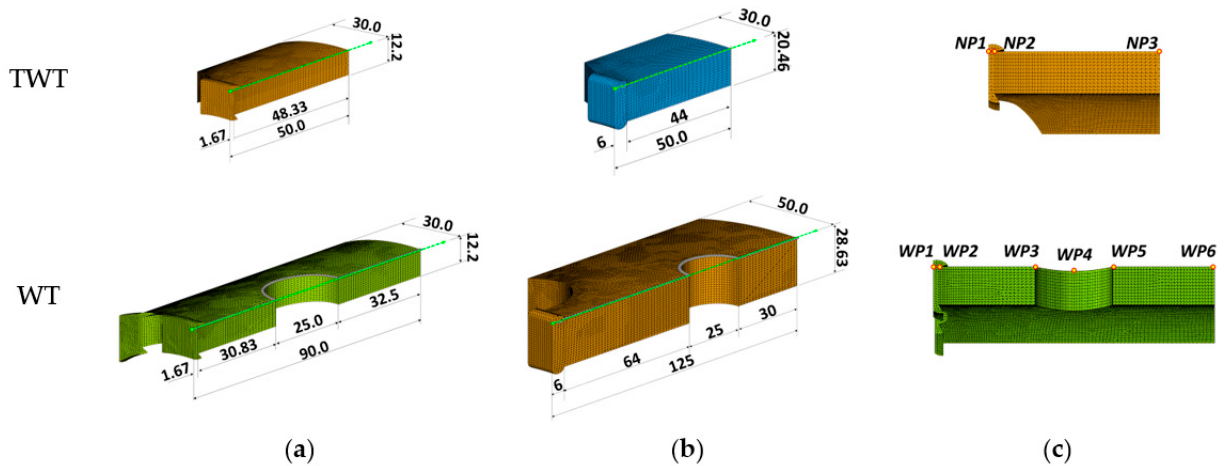
Figure 11. Specimen and grip assembly dimensions for FE analysis (unit: mm): ( a ) TWT; ( b ) WT.